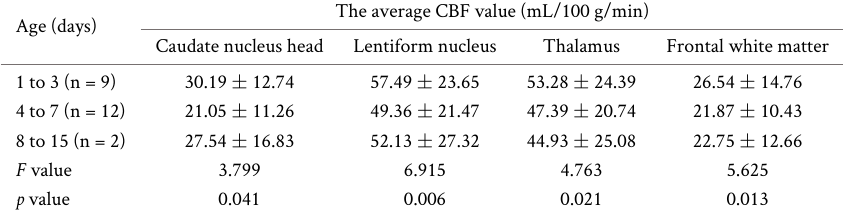
Table 4. The CBF values in different age groups of HIE neonates.